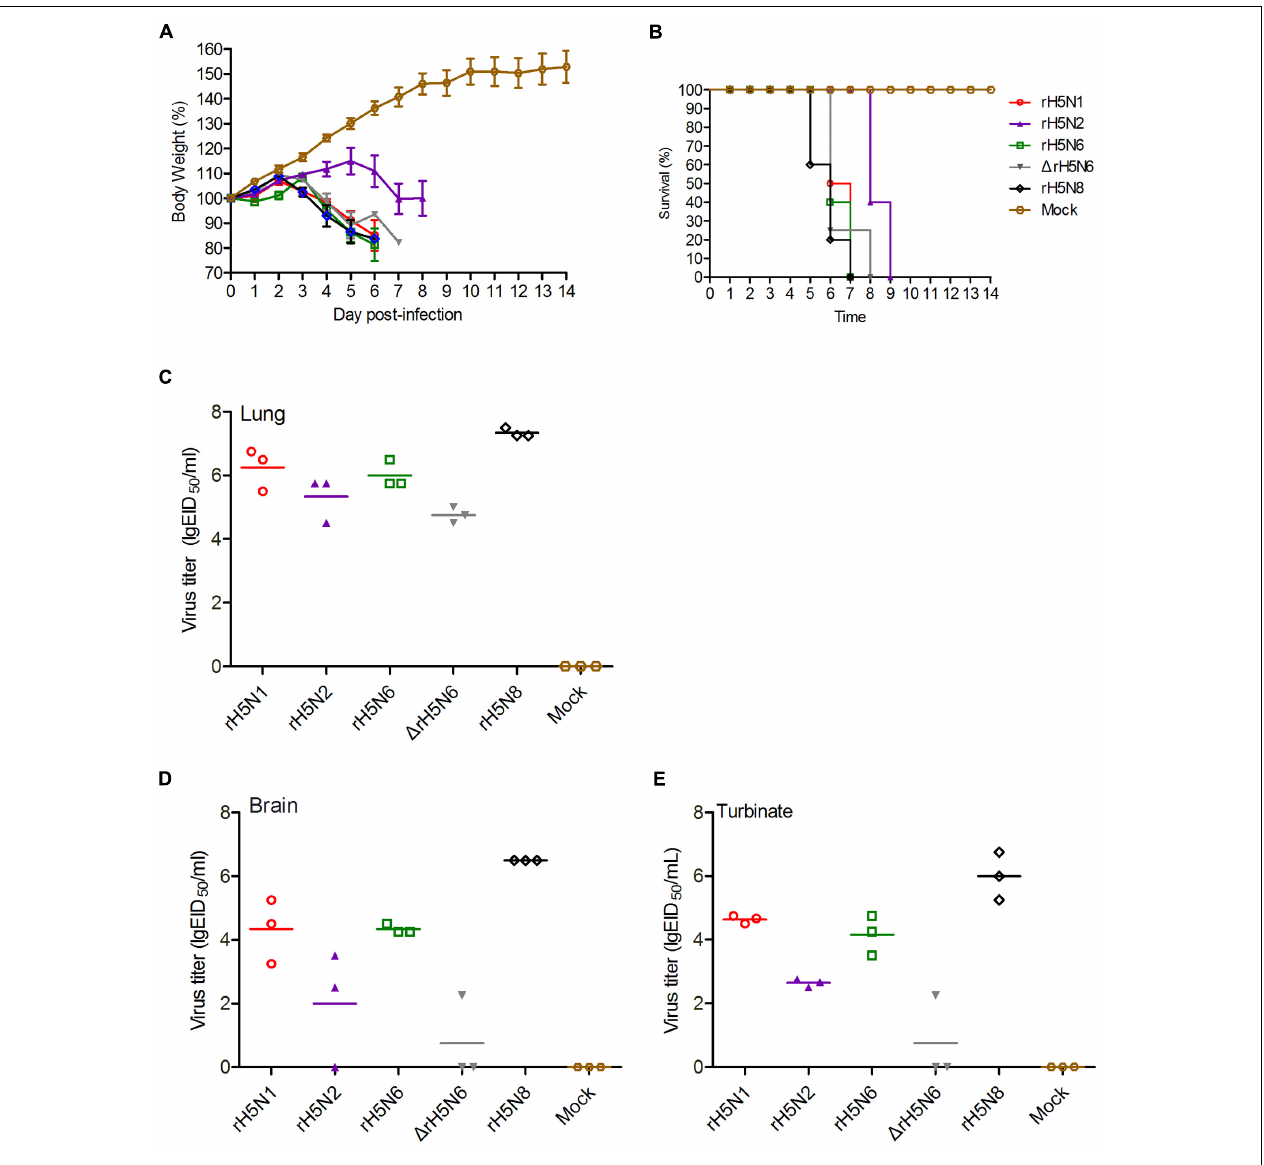
FIGURE 4 | Pathogenicity of the of H5Nx reassortant viruses in mice. Groups of eight female BALB/c mice were intranasally inoculated with 10 5 EID 50 /50 µ l of the indicated viruses or with PBS as a negative control. Mouse body weight (A) and survival (B) were monitored daily for 14 days. Mice that lost more than 25% of their initial weight were euthanized. The percentage weight from each group and each time point are presented as means ± SD. The titers of viruses were detected in organs lung (C) , brain (D) , turbinate (E) . Three mice from each group were euthanized on 4 days post-inoculation